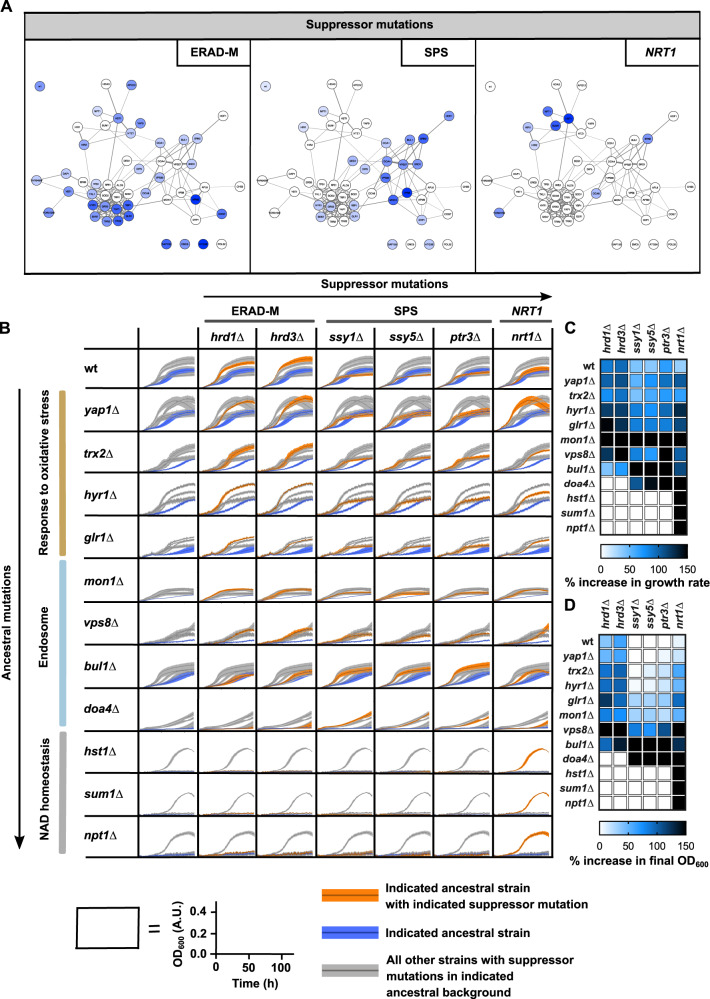
Validation of module-specific adaptation. (A) Mutations in ERAD-M, SPS, or NRT1, projected onto the original gene deletion network with genes important for resistance to paraquat stress. The intensity of the colors corresponds to the relative frequency of individually evolved clones with a mutation in the indicated complex, pathway or gene. (B) Growth curves of double deletion mutants (ancestral deletion and adaptive deletion) on YP 2% (w/v) glycerol with 0.125 mM paraquat. Each row contains one of the original genetic backgrounds that were used during experimental evolution, and each column contains deletions in genes that were indicated to be adaptive. Dark blue curves represent the growth of the ancestor strain without any other additional deletions (first column), orange curves correspond to the growth of the double deletion strain indicated by the row and column headings, and gray curves represent growth curves of all other strains within the same row. Error bars represent the standard deviation of four replicates. (C) Heat map with the increase in growth rate for each combination of deletions. (D) Heat map with the increase in final OD600 for each combination of deletions.